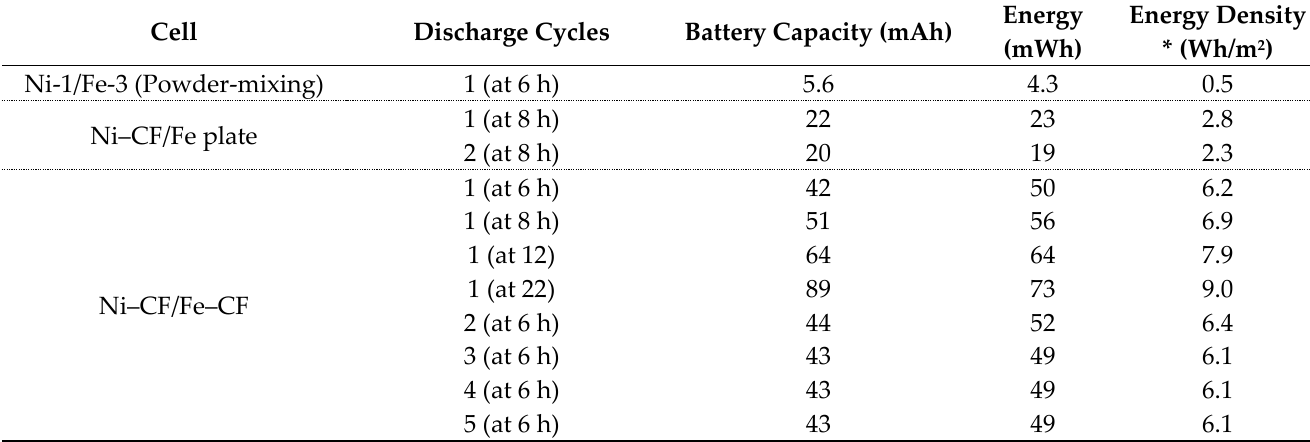
Figure 9. A detailed potential and current profile of discharge cycle 1 of the Ni-Fe cell. Measure- ments include the potential difference between the cathode and anode (dE2), the potential of the iron plate as anode (E_Fe, V_ SCE ), the potential of the Ni-CF cathode (E_Ni, V_ SCE ), and the current with a 165 Ω resistor. Table 12. Summary of cell performance tested in alkali solution as electrolyte.